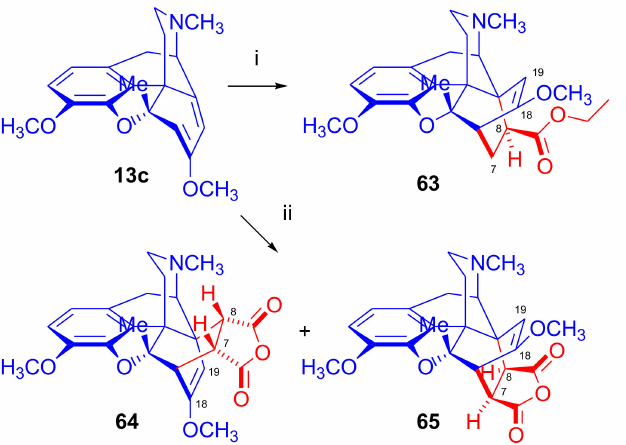
Figure 20. Reactions of 7-methoxy-5 β -methyl-6-demethoxythebaine. Reagents and conditions : (i): ethyl acrylate, reflux, 2 weeks, 62%; (ii) three equiv. maleic anhydride, toluene, reflux, 4